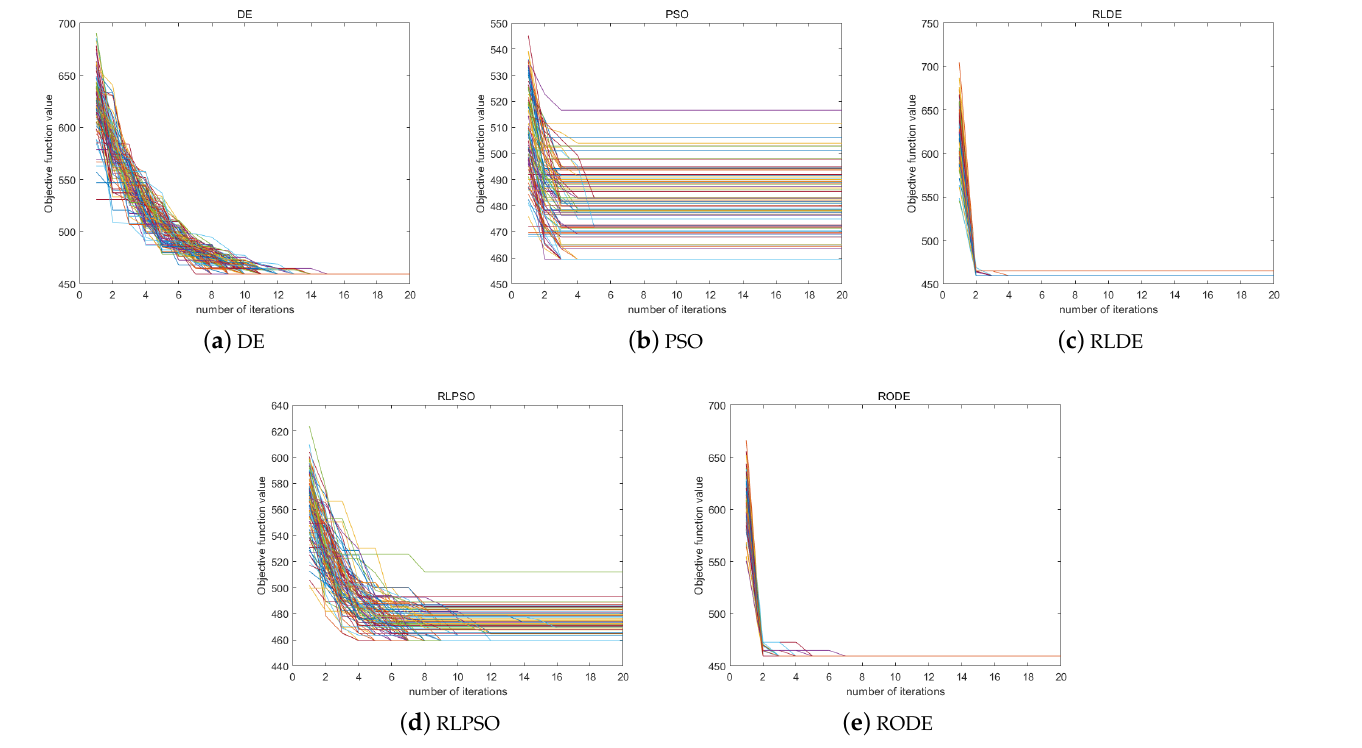
Figure 10. Algorithm convergence test when the initial population size is 200. ( a ) DE algorithm runs 100 times. ( b ) PSO algorithm runs 100 times. ( c ) RLDE algorithm runs 100 times. ( d ) RLPSO algorithm runs 100 times. ( e ) RODE algorithm runs 100